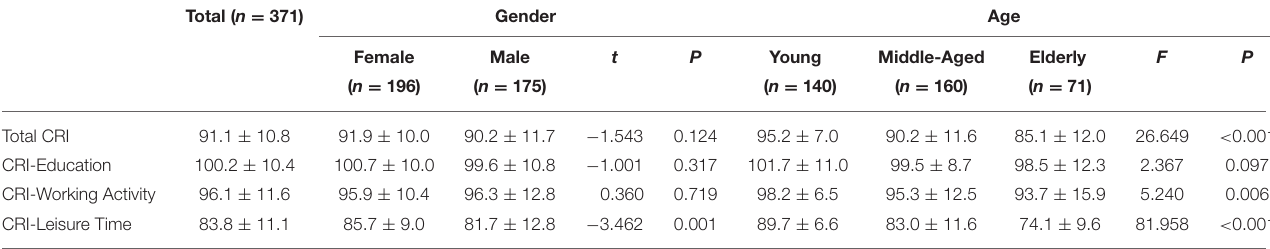
TABLE 4 | The mean and standard deviation of CRI scores for gender and